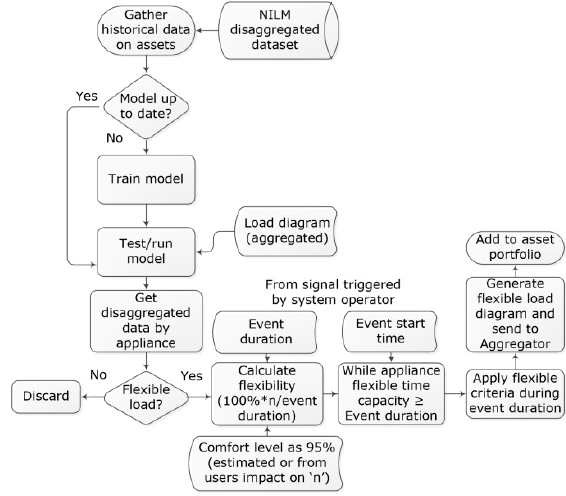
Figure 2. Model implementation diagram for load flexibility estimation.